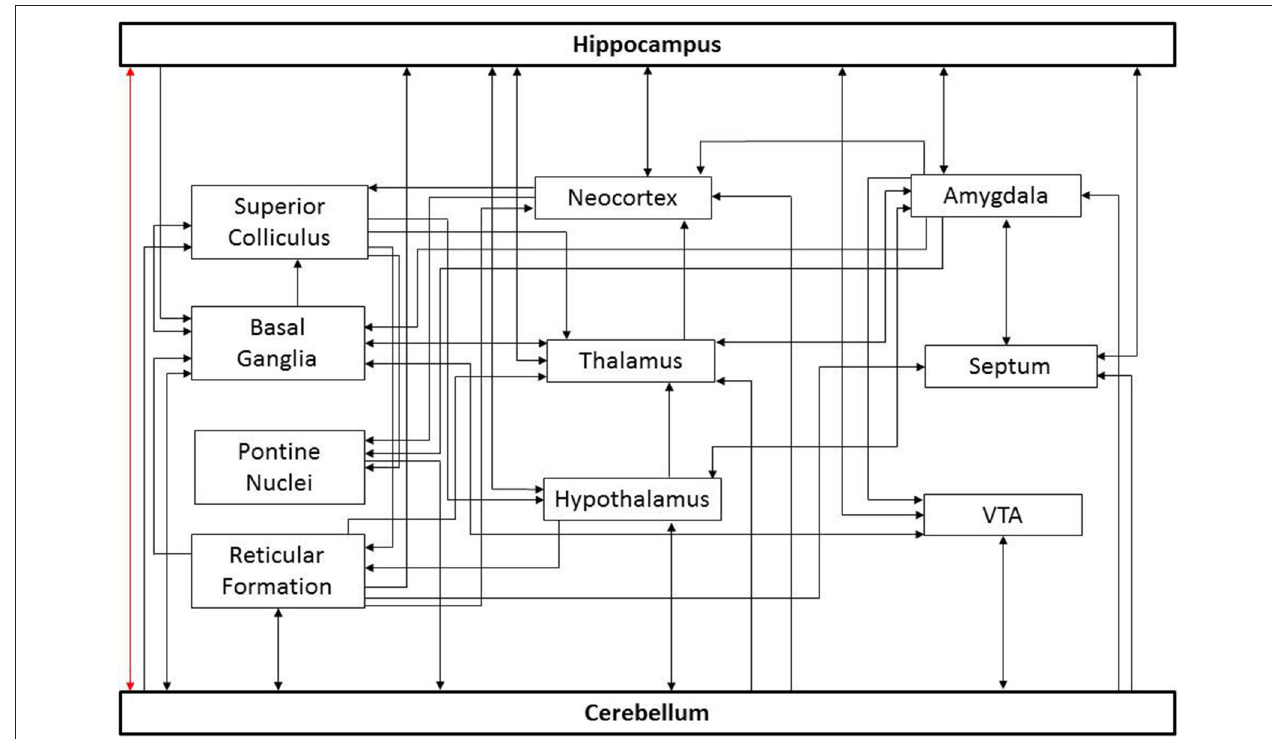
FIGURE 1 | Potential paths of influence. This simplified diagram illustrates potential pathways underlying cerebello-hippocampal functional connectivity. For the sake of simplicity, only general connections between structures are shown; important subdivisions of depicted structures have been omitted. Similarly, only a subset of potential routes is depicted. As noted in the text, there is controversy surrounding a potential direct connection between these structures (red arrow). Additional connections depicted include input to the cerebellum from the basal ganglia (Bostan and Strick, 2010), reticular formation (Pierce et al., 1977; Verveer et al., 1997; Luo and Sugihara, 2014), pontine nuclei (Kawamura and Hashikawa, 1981), hypothalamus (Dietrichs and Haines, 1984, 1986, 1989; Onat and Cavdar, 2003), and ventral tegmental area (VTA) (Snider et al., 1976; Oades and Halliday, 1987); projections from the cerebellum to the superior colliculus (Person et al., 1986a), basal ganglia (Bostan and Strick, 2010), reticular formation (Elisevich et al., 1985; Person et al., 1986b; Perciavalle et al., 1989; Teune et al., 2000; Almeida et al., 2002), hypothalamus (Dietrichs and Haines, 1989; Onat and Cavdar, 2003), thalamus (Haroian et al., 1981; Asanuma et al., 1983; Angaut et al., 1985; Person et al., 1986a), neocortex (Harper and Heath, 1973; Clower et al., 2005), VTA (Oades and Halliday, 1987; Snider et al., 1976), septum (Paul et al., 1973; Heath et al., 1978), and amygdala (Heath and Harper, 1974); projections to the hippocampus from the neocortex (Canto et al., 2008; Ohara et al., 2013), septum (Ohara et al., 2013), reticular formation (Lewis and Shute, 1967; Köhler and Steinbusch, 1982; Andersen et al., 1983), hypothalamus (Lima et al., 2013; Soussi et al., 2015), thalamus (Vertes, 2015), VTA (Kahn and Shohamy, 2013) and amygdala (French et al., 2003); projections from the hippocampus to the amygdala (Ishikawa and Nakamura, 2006), basal ganglia (Floresco et al., 2001), hypothalamus (Swanson and Cowan, 1977), thalamus (Swanson and Cowan, 1977), neocortex (Swanson and Cowan, 1977), VTA (Kahn and Shohamy, 2013), and septum (Swanson and Cowan, 1977). Similarly, connections exist between these intermediate structures which may indirectly influence the cerebellum and